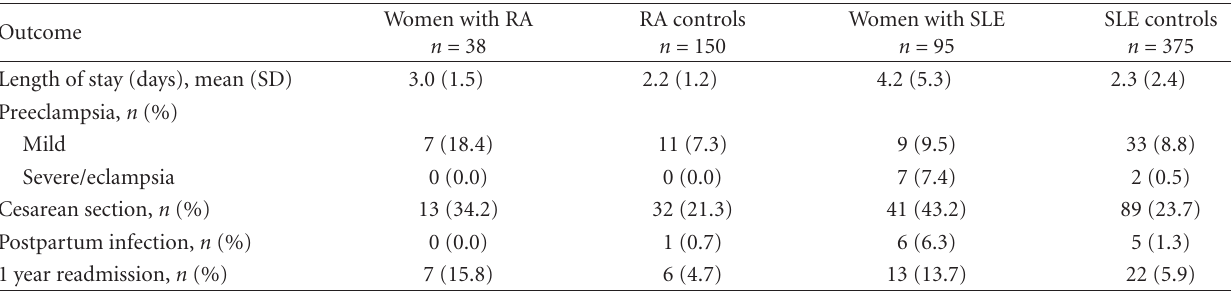
Table 1: Summary of maternal outcomes.